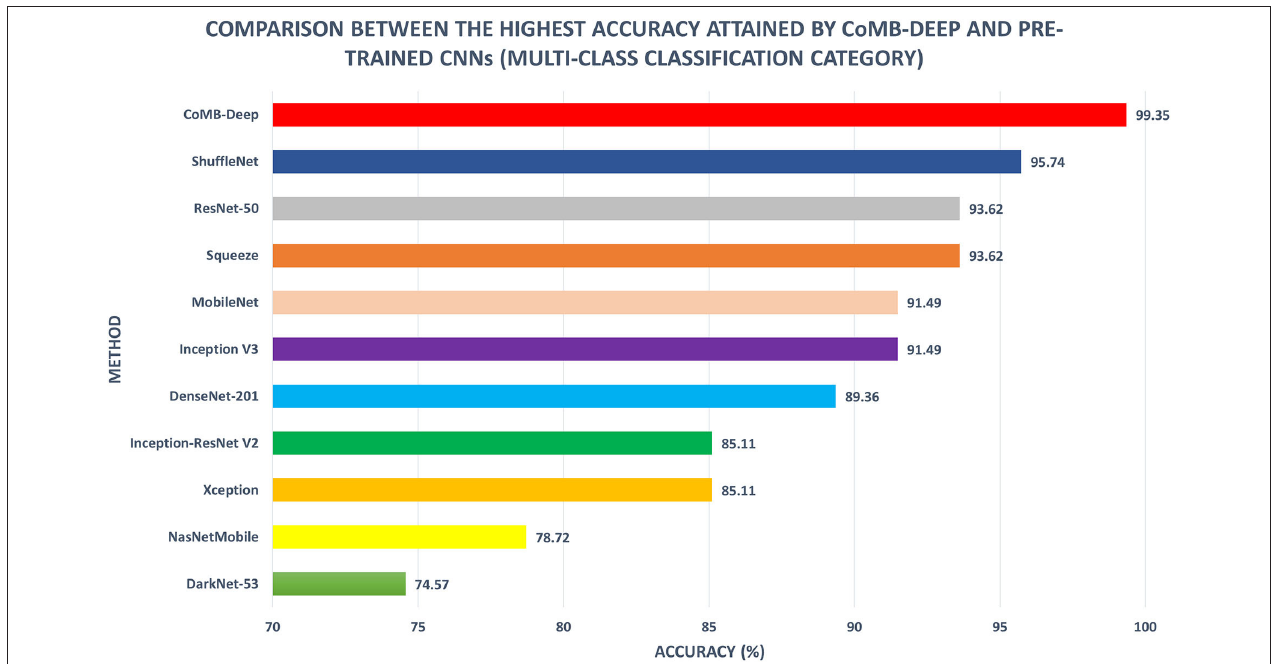
FIGURE 8 | Multi-class classification accuracy (%) of CoMB-Deep compared to end-to-end deep learning classification of 10 CNNs.